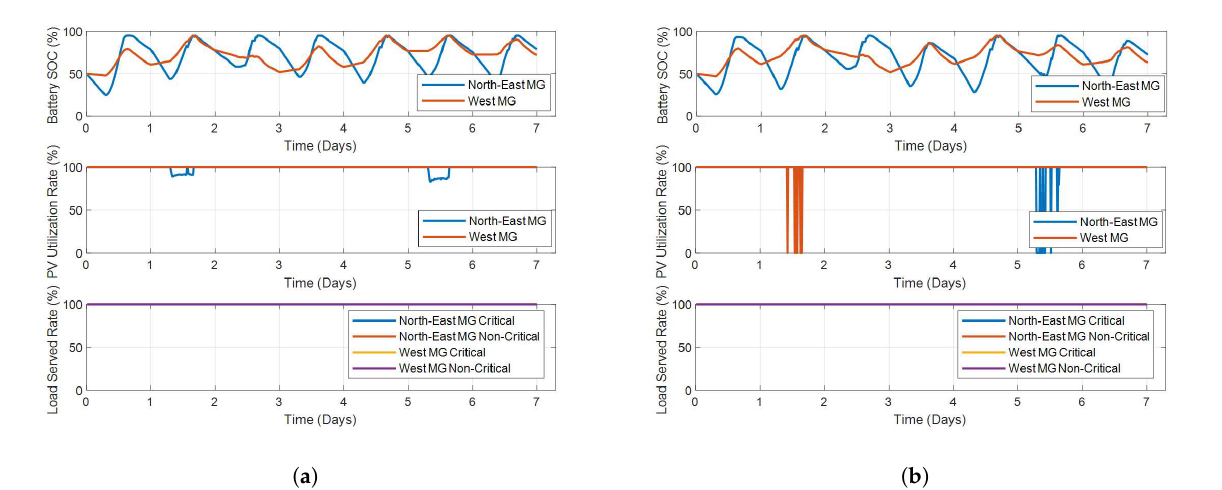
Figure 15. Optimization results of Adjuntas 2-microgrid system in Case 3. ( a ) Centralized Method. ( b ) Distributed Method.